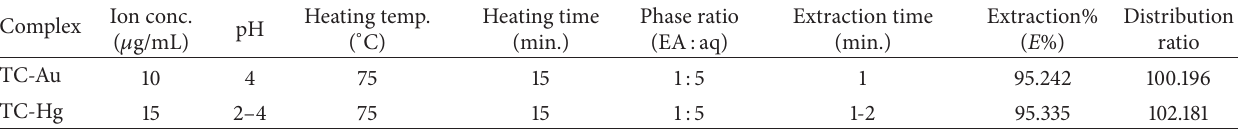
Table 1: Optimum experimental conditions for TC. HCl complexes with Au(III) and Hg(II) ions. Ion Complex